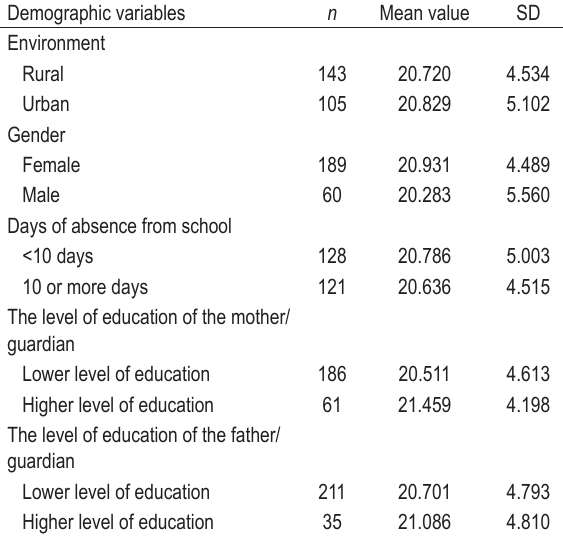
TABLE 3. The average value on the health literacy test according to environment gender, days of absence from school, and the level